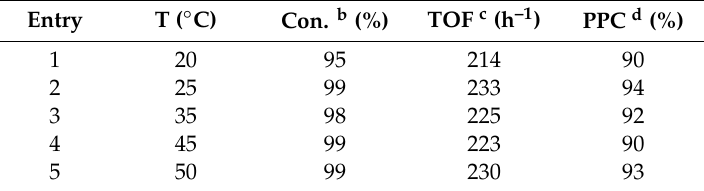
Table 2. (Salen- 4 )[Co(III)TFA] 2 / [PPN]TFA catalyzed PO / CO 2 copolymerization at different temperatures a .